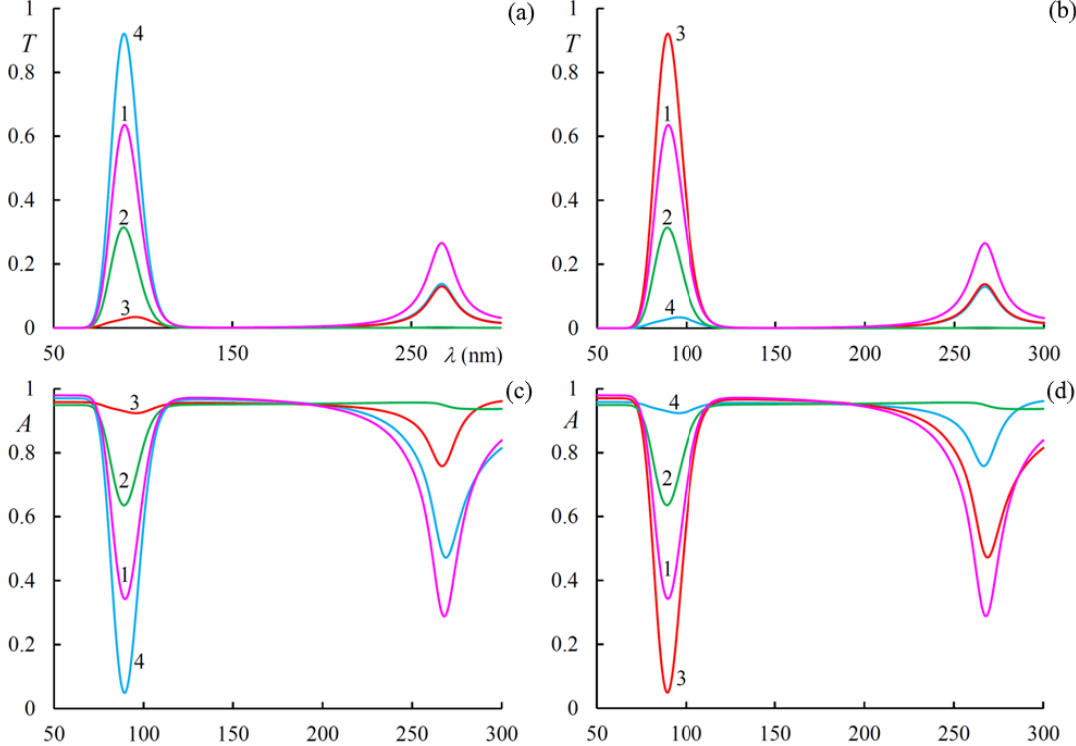
Figure 5. The transmission ( a , b ) and absorption ( c , d ) spectra at g = 0.3 for ( a , c ) Im𝜀 1 = 0.2 , Im𝜀 2 = 0. , and ( b , d ) Im𝜀 1 = 0. , Im𝜀 2 = 0.2 . Curves 1, 2, 3, and 4 are enumerated according to the right circular, left circular, linear along the x axis, and linear along y axis polarizations, correspondingly.